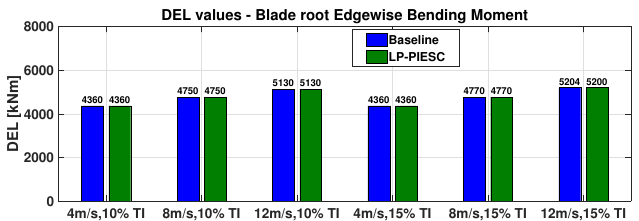
Figure 31. Blade root edge-wise bending moment comparison: Baseline vs. LP-PIESC. Aggregate DEL values with baseline controller and LP-PIESC for time series from 150 s to 3000 s.